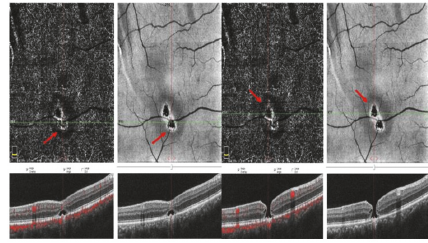
Figure 4: At first month of examination full thickness retinal hole formation and ellipsoid zone damage at the superior and inferior margin of the inferior temporal arterial vascular arcade were seen on en face optical coherence tomography (OCT) angiogram of OCT angiography (red arrows).